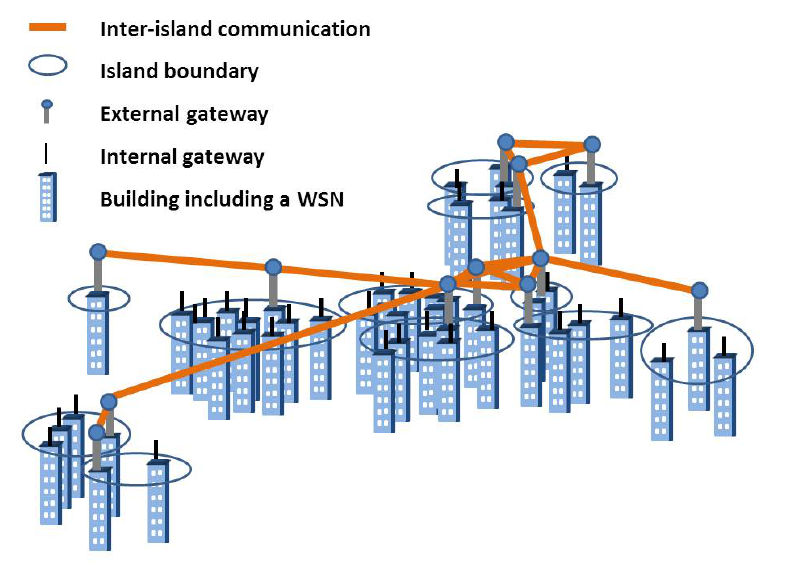
Figure 3. FSN topology in University at Buffalo, State University of New York. Table 2. Simulation parameters for the layered and flat Federated Sensor Network